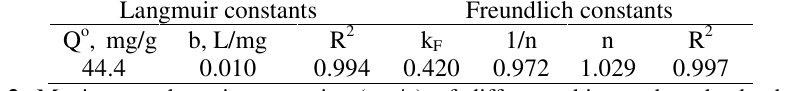
Table 1. Langmuir and Freundlich constants for adsorption of fluoride on CCS.